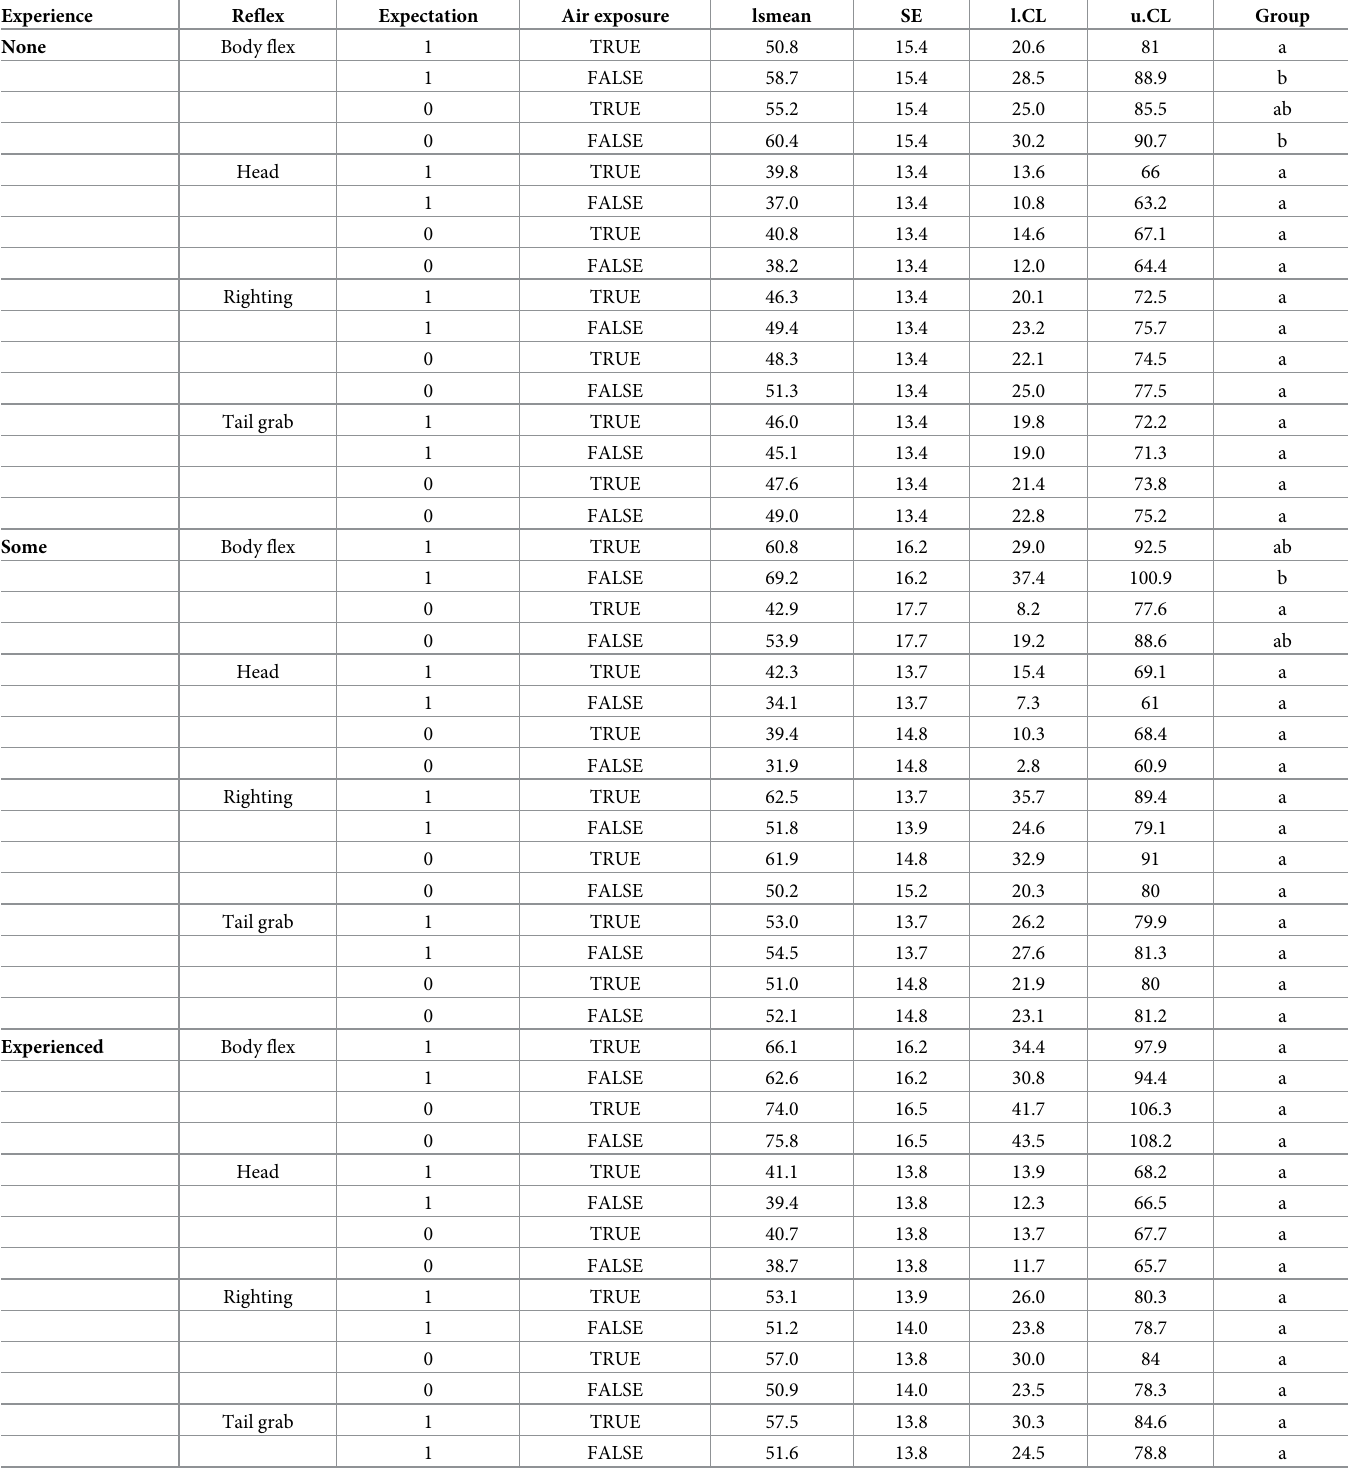
Table 4. Tukey comparisons of the least-square mean (lsmean) ± SE reflex score of a given reflex type which was scored by a rater with a certain experience and a positive (1) or negative (0) expectation. Experience Reflex None